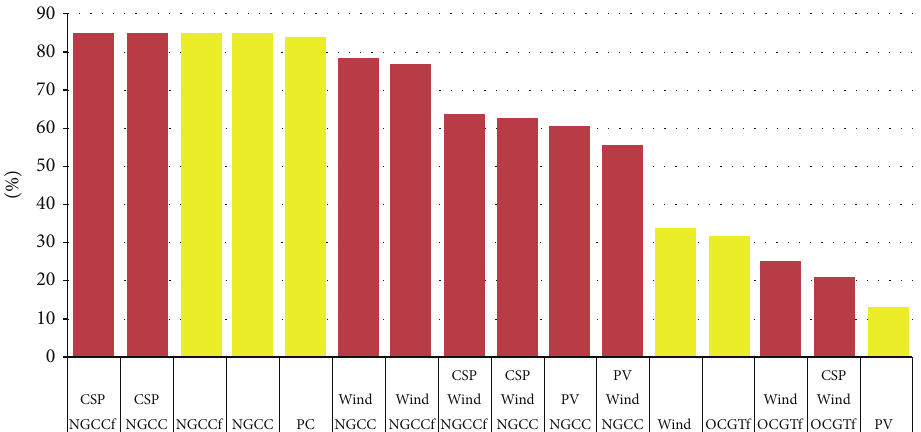
Figure 5: Total capacity factor of combined energy sources and stand-alone cases.